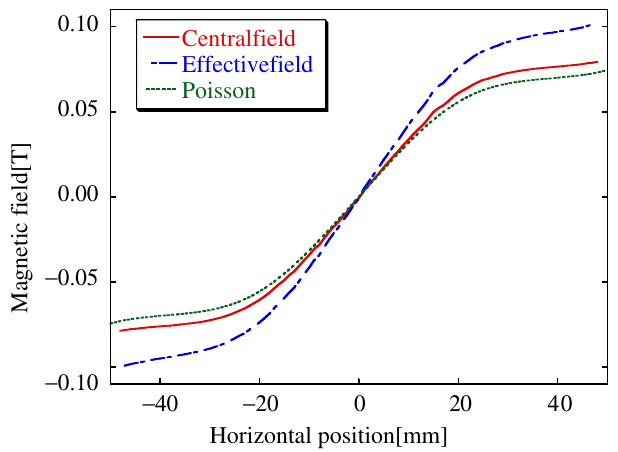
FIG. 15. (Color) Calculated and measured field strengths of the PQM as a function of the horizontal position. The lines represent the measured central field strength, measured effective field strength, and calculated field strength.